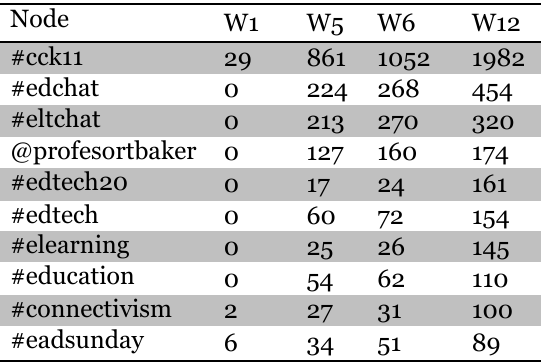
Table 2 Distribution of Weighted Input Degree for Weeks 1, 5, 6, and 12, for the Top 10 Ranked Nodes within the Last